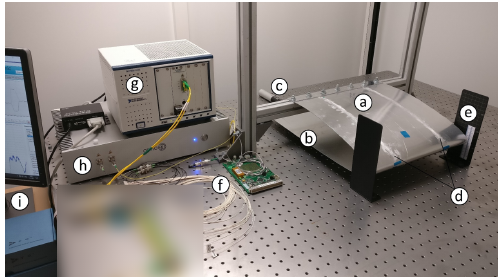
Figure 4. The experimental setup showing the test wing’s (a) fixed top surface, (b) sliding bottom surface, (c) actuator (up close in Figures 5 and 6) , (d) sensing fibres (e) vertical scales, (f) optical switch, (g) National Instruments interrogator, (h) Optics11 interrogator and the (i) data acquisition system. The top section of the wing was bolted to the top of the horizontal cross bar. It was positioned at the centre of the cross bar making it ~120 mm from each of the vertical uprights. On the other hand, the bottom section of the wing was left to hang under gravity. The only connection point of the wing to the horizontal crossbar was the top section of the